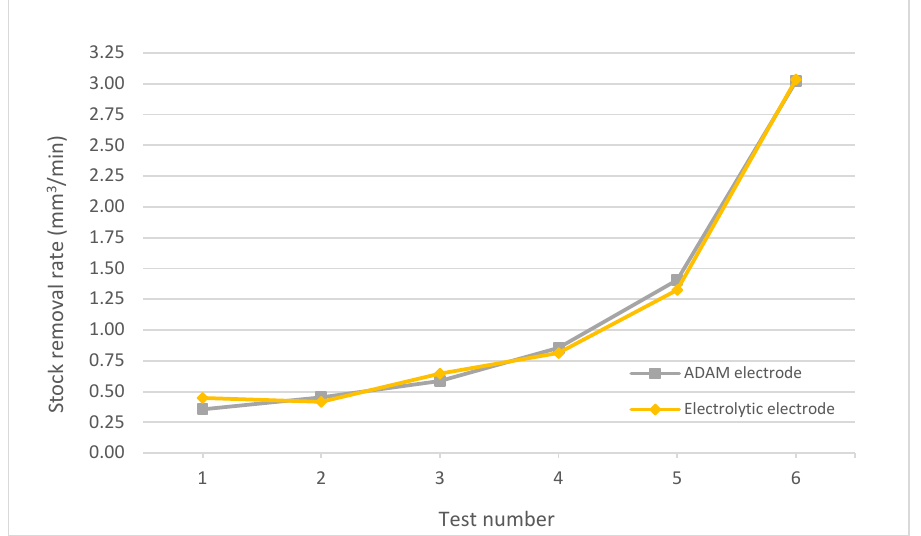
Figure 12. Stock removal rates for electrolytic and ADAM copper electrodes. Finally, Figure 13 shows the behavior of the electrodes in terms of wear rate. In this case, the wear rate of the ADAM electrode was more pronounced than that of the electrolytic electrode in practically all the tests except for number 5 (almost identical wear rates). In the remaining tests, the wear rates of the electrolytic electrode were close to half of the wear rates of the ADAM electrode, with values that ranged between 40.8% and 52.1% of those of the ADAM electrode.